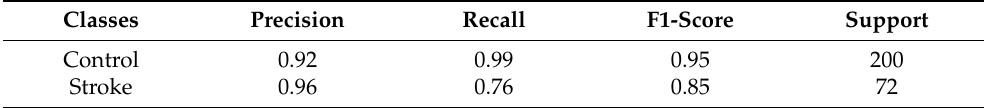
Table 3. Random Forest model classification